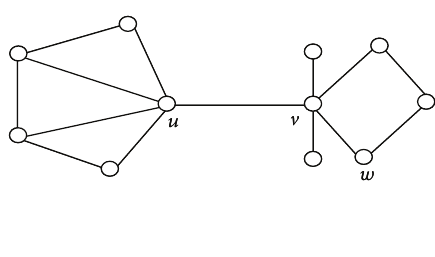
Figure 1: Graph with